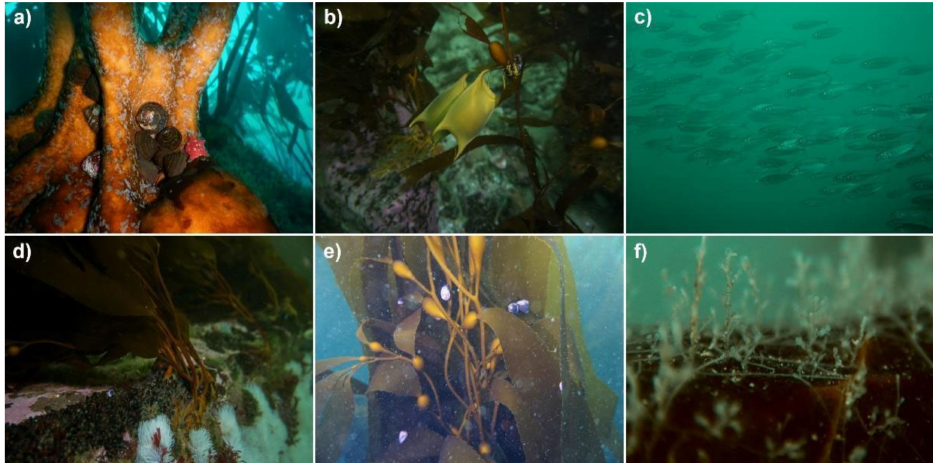
Figure 3. Supporting services of kelp forests along the Humboldt Current System. The genus Lessonia usually forms a second canopy ( a ), while Macrocystis pyrifera forms an upper canopy ( e ). Kelp forests support habitats for a wide range of fauna, such as motile invertebrates (Pichidangui, Chile) ( a ); chondrichthyans that use kelp structures to deposit their capsules (Pucusana, Peru) ( b ); osteichthyes ( Trachurus murphyi Nichols 1920; Pucusana, Peru) ( c ); and sessile organisms (Pucusana, Peru) ( d , f